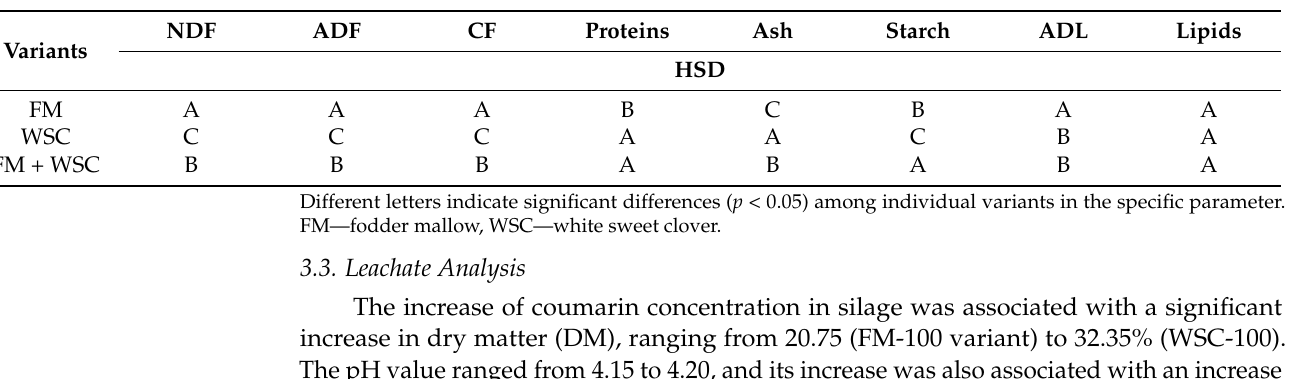
Table 5. Parameters of silage variants FM, WSC and their mixture.